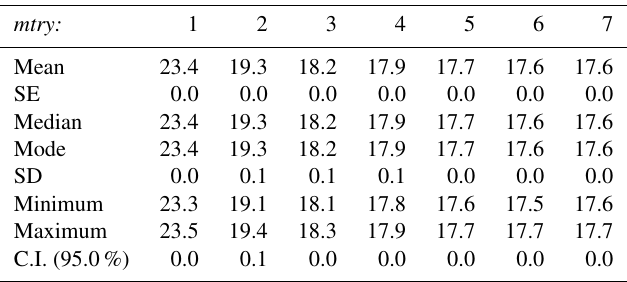
Table B3. Descriptive statistics of MSR from different number of the mtry parameter, after 10 iterations with 80% of the sample as training data and ntree = 600.